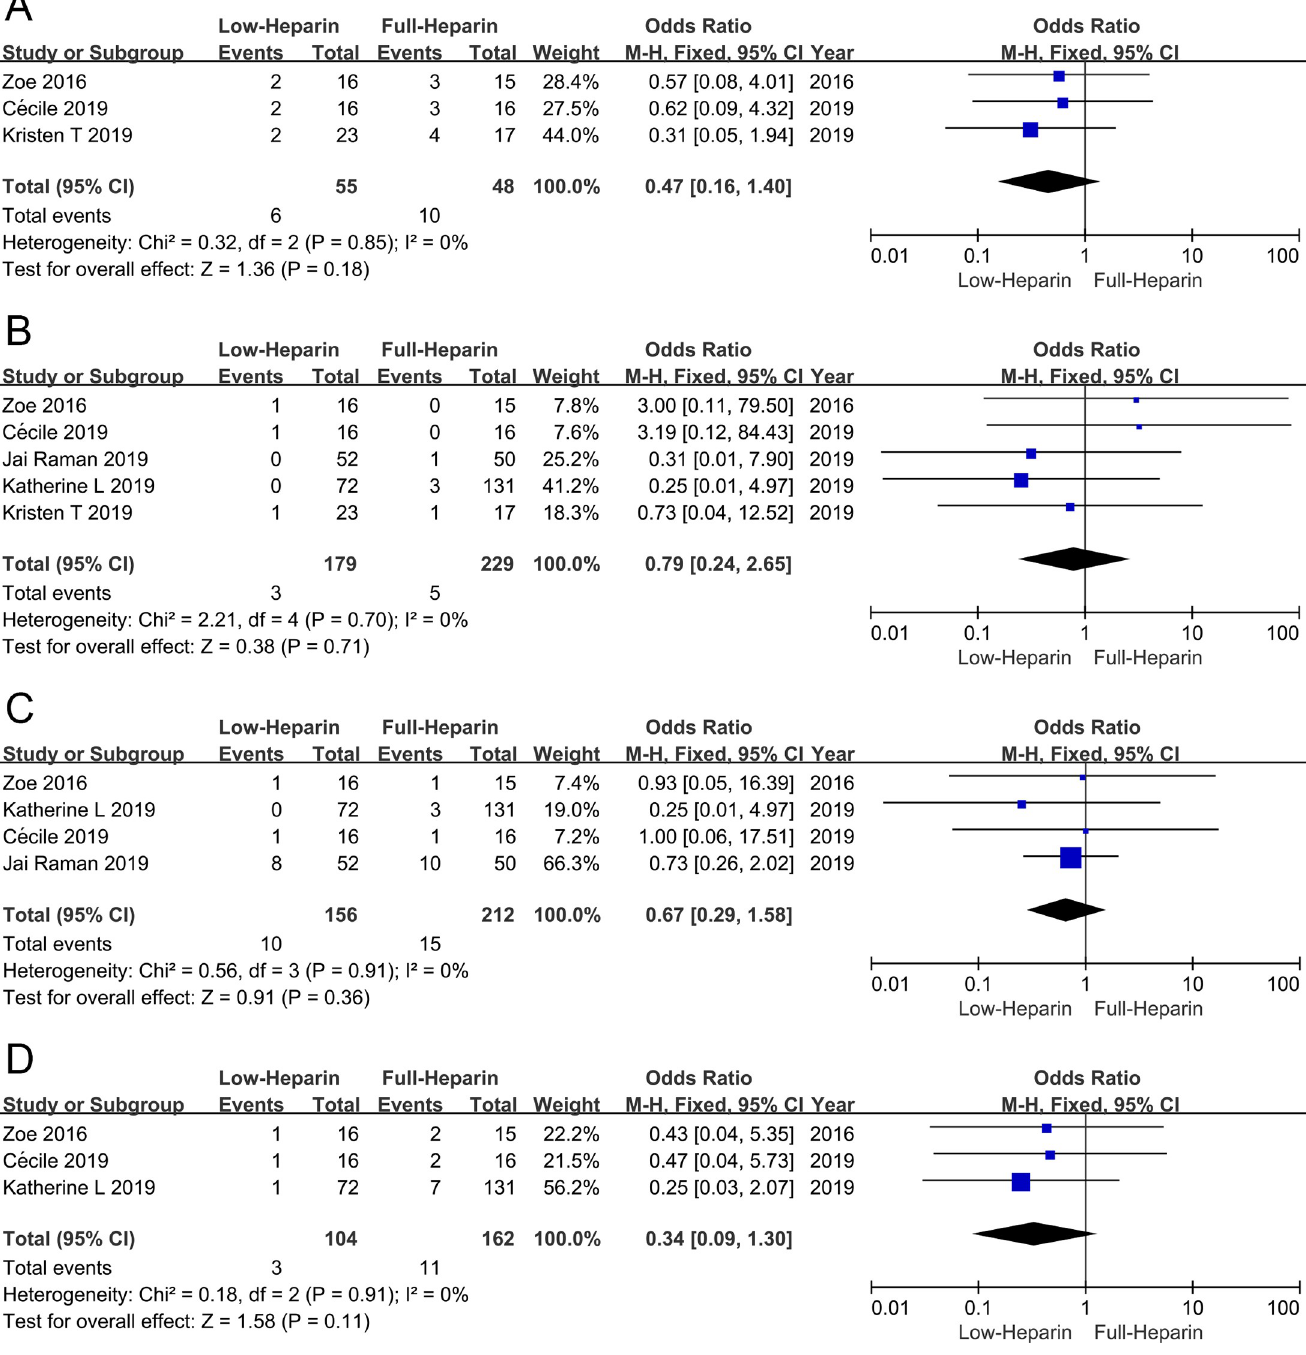
Fig 4. Forest plots of meta-analysis in thrombotic outcomes. (A) Forest plot of OR of deep vein thrombosis. (B) Forest plot of OR of pulmonary embolism. (C) Forest plot of OR of clots in the oxygenator and pump. (D) Forest plot of OR of intracardiac